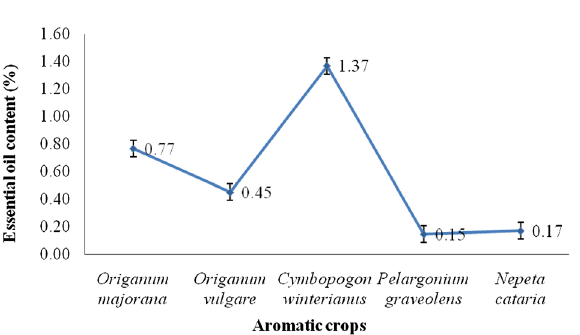
Figure 2. Essential oil content of aromatic medicinal plants grown in the mid hill conditions of the western